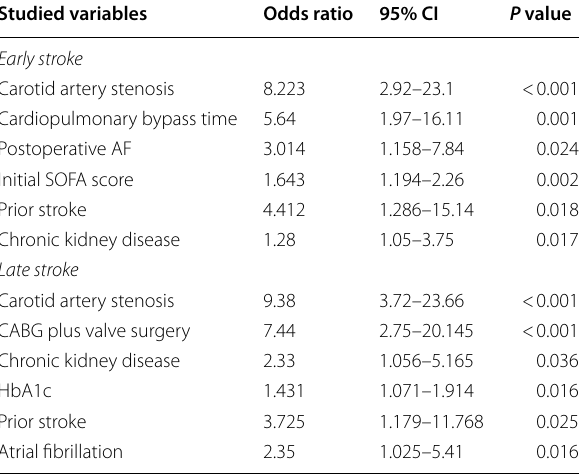
Table 4 Multivariate regression analysis Studied